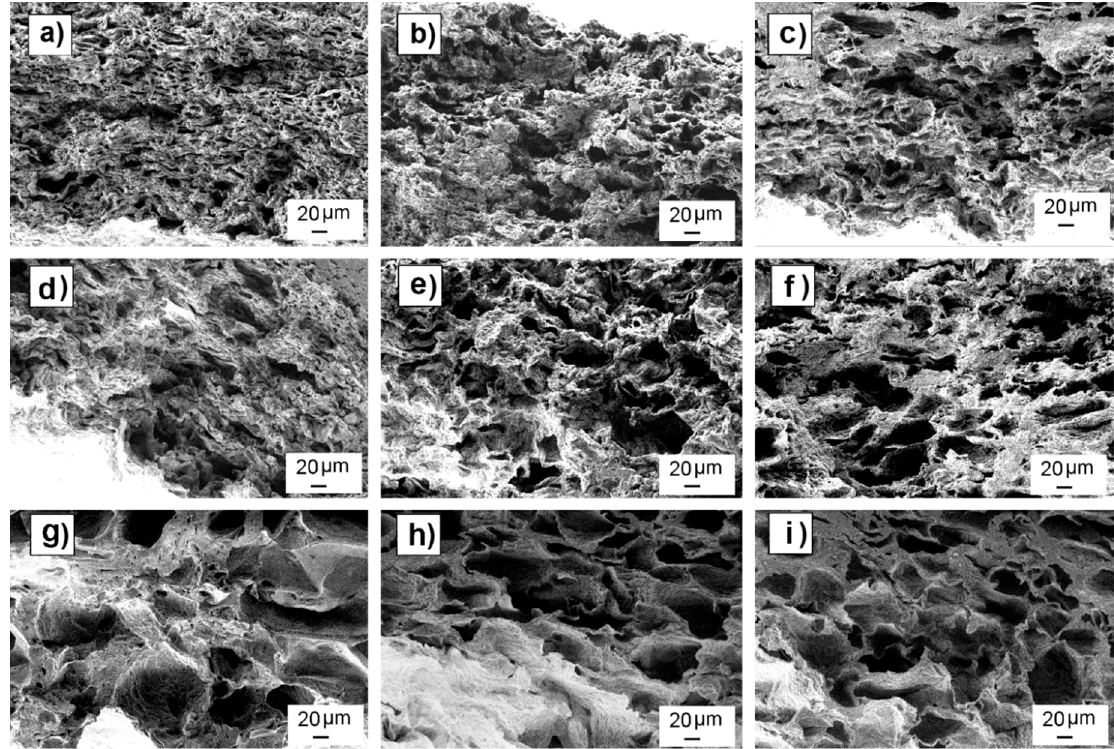
Figure 2. SEM images of nine different leached scaffolds arranged by their particle size range (row) and porogenerator weight proportion amount (column). Scaffolds made with particles in 0–50-µm range and proportion of 50 wt.% ( a ); 60 wt.% ( b ); and 70 wt.% ( c ); scaffolds made with particles in 25–50-µm range and proportion of 50 wt.% ( d ); 60 wt.% ( e ); 70 wt.% ( f ); scaffolds made with particles in 50–100-µm range and proportion of 50 wt.% ( g ); 60 wt.% ( h ), and 70 wt.% ( i ). Table 2. Mean values and standard deviation of Feret diameter of ellipsoids adjusted to the pore shapes in leached samples with 50%, 60% and 70 wt.% of pore densities and particle sizes in 0–50, 25–50, and 50–100-µm ranges.